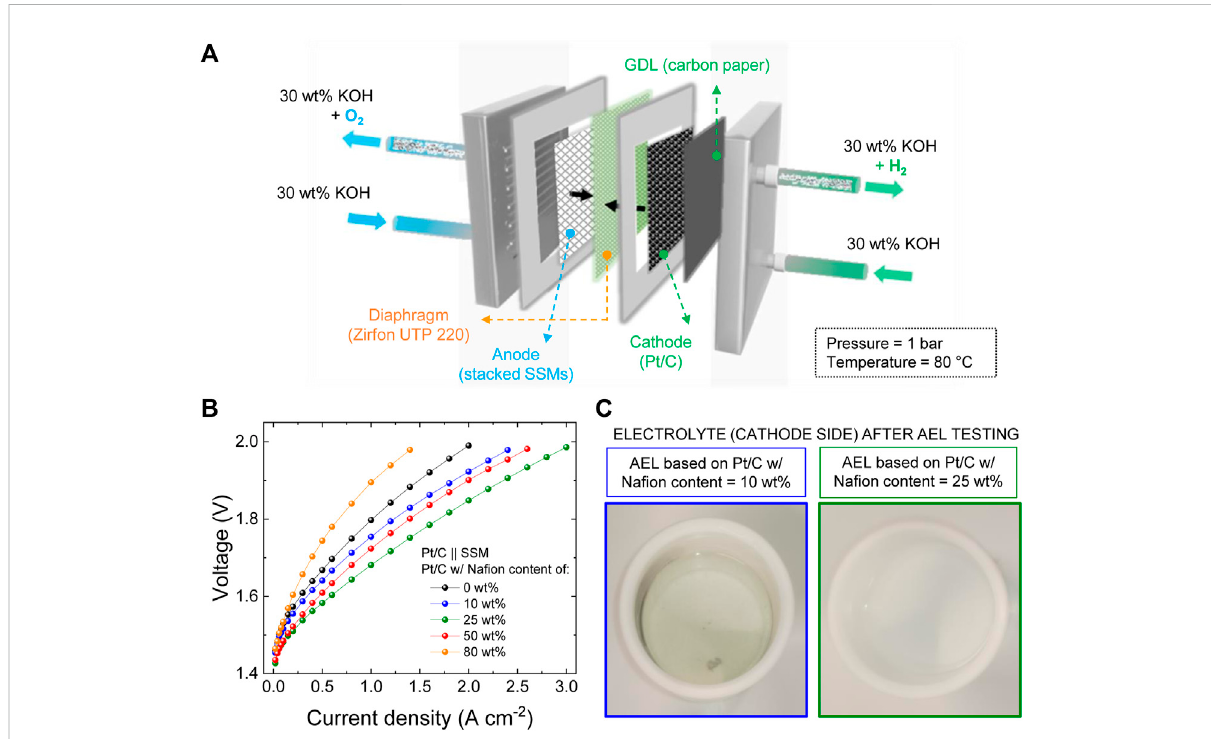
FIGURE 2 (A) Sketch of the con fi guration of our Pt/C || SSM AELs based on: a Pt/C cathode (+ CPR GDL), a SSM anode and a Zirfon UTP 220 diaphragm. Operating conditions: 30 wt% KOH electrolyte solution; atmospheric pressure (1 bar); 80 ° C temperature; 30 ml min − 1 fl ow rate. (B) Galvanostatic polarization curves measured for the AELs based on the Pt/C cathodes (m Pt ~300 μ g cm − 2 ) produced with different Na fi on contents in the catalyst coatings, from0 wt%(binder-freecathode)to80 wt%. (C) Picturesofthepost-test(10CVcyclesandpolarizationcurveacquisition)electrolyte (cathode side) of the AELs based on the Pt/C cathode produced with a Na fi on content of 10 wt% (left side) and 25 wt% (right